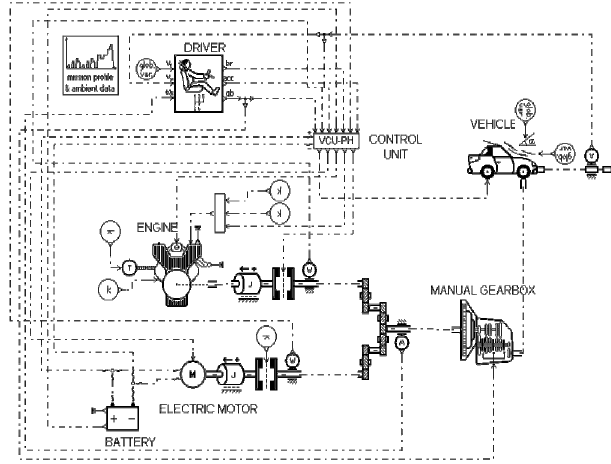
Fig 12. Simulation model of hybrid vehicle with parallel drive realized with AMESim software